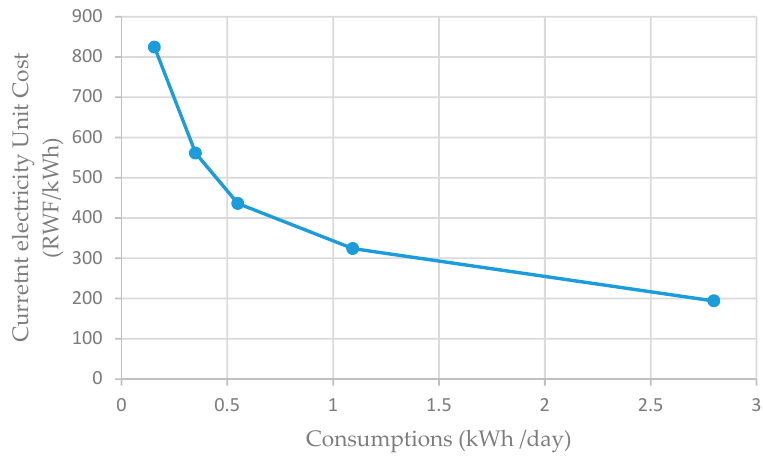
Figure 3. Correlation between Current Electricity Unit Cost and Consumptions.